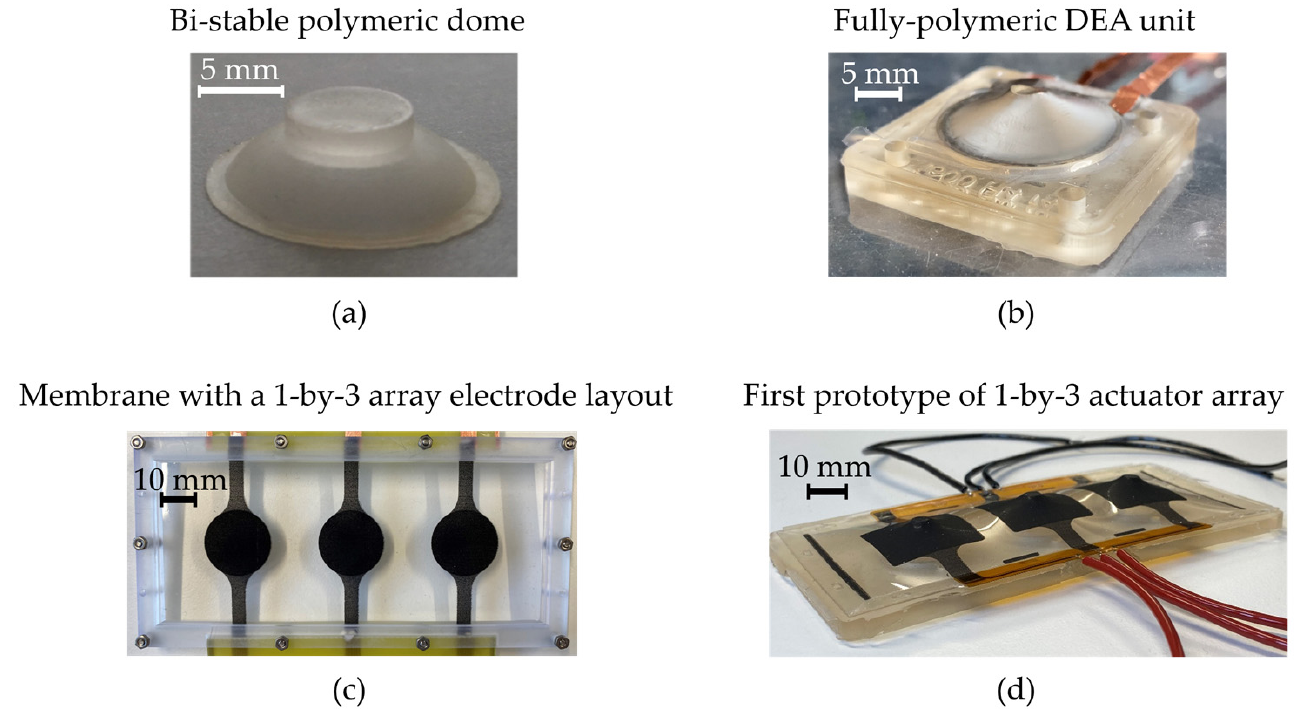
Figure 7. Fully polymeric DEA array developed in the context of the DECMAS project: ( a ) Bi-stable polymeric dome; ( b ) Fully polymeric DEA unit; ( c ) Silicone membrane with a screen-printed 1-by-3 electrode layout; ( d ) First prototype of 1-by-3 actuator array.